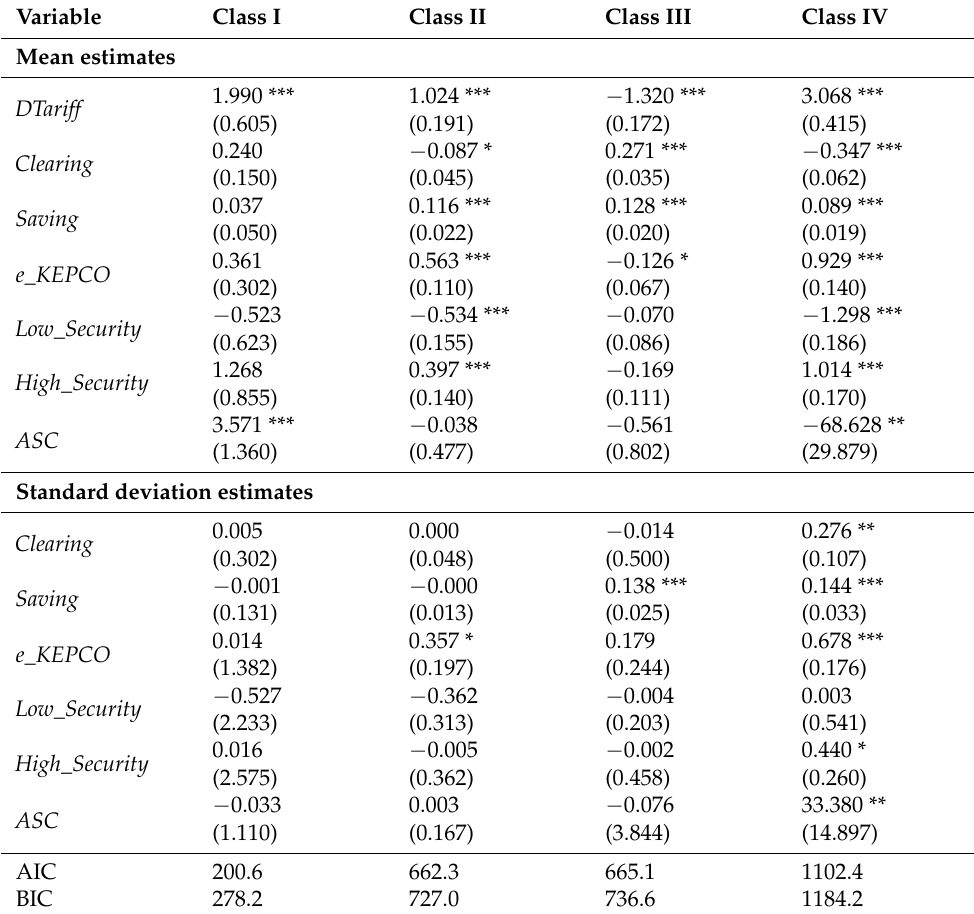
Table 8. Hybrid Model